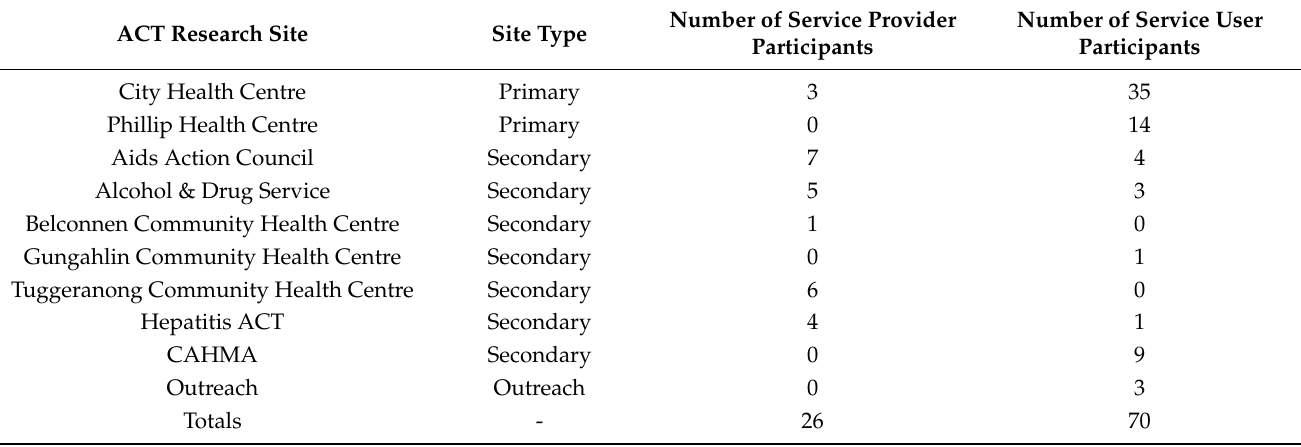
Table 3. Summary of survey participants by